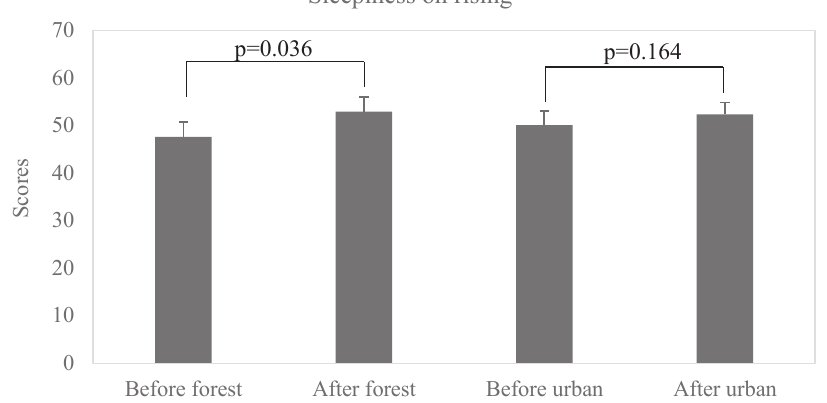
Fig. 5 E ff ect of forest bathing on subjective sleep quality (sleepiness on rising). p = 0.036, between before and after forest bathing, p = 0.164 between before and after walking in the urban area by paired t-test (Mean + SD, n = 10). “ Before forest ” means before the forest bathing, “ After forest ” means after the forest bathing, “ Before urban ” means before the walking in the urban area, and “ After urban ” means after the the walking in the urban